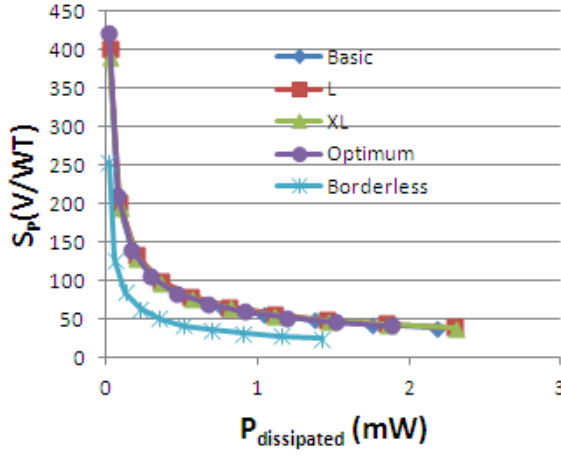
Figure 22. Power-related sensitivity vs. the dissipated power for the simulated Hall Effect devices.